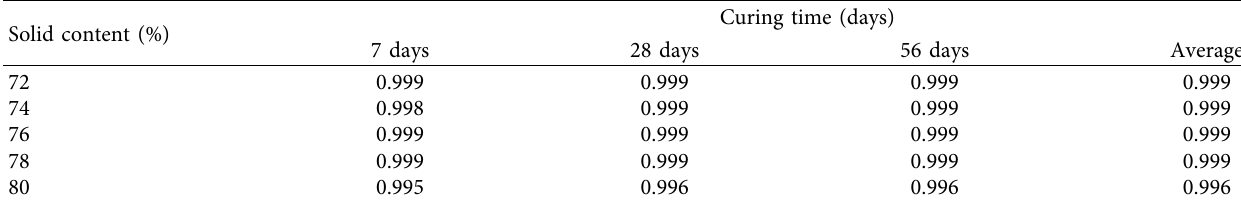
Table 16: UCS results of CUTB samples under various c/t ratios.